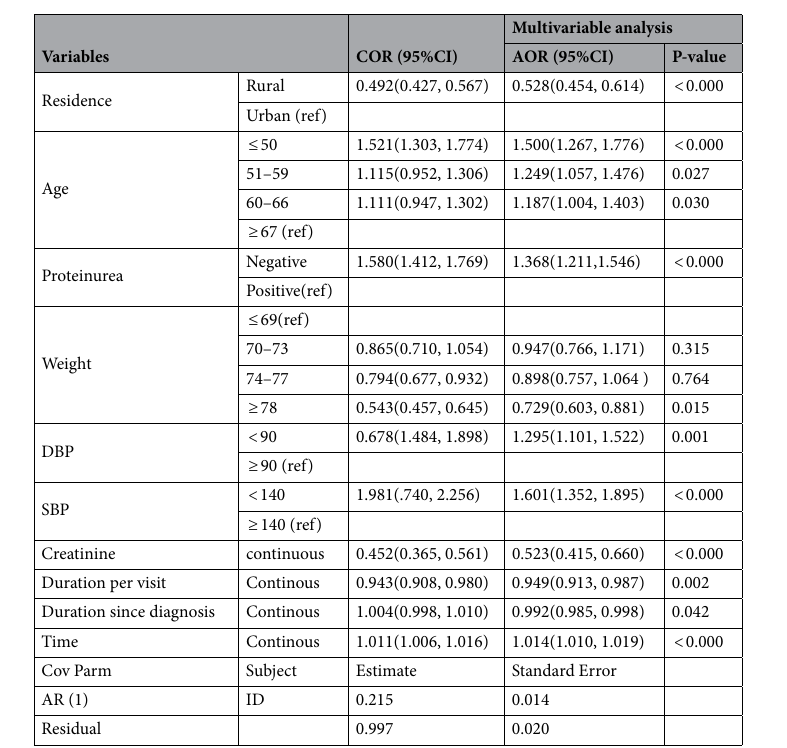
Table 3. Results of Generalized Linear Mixed model with logit link for factors associated with glycemic control for 191 type 2 diabetes mellitus patients with 1740 glycimic control status observations. AR (1) autoregressive order one, AOR adjusted odd ratio, COR crud odd ratio, CovParm covariance parameter, DBP diastolic blood pressure, SBP systolic blood pressure, ref reference group, 95%CI 95% Confidence interval, P-value Probability